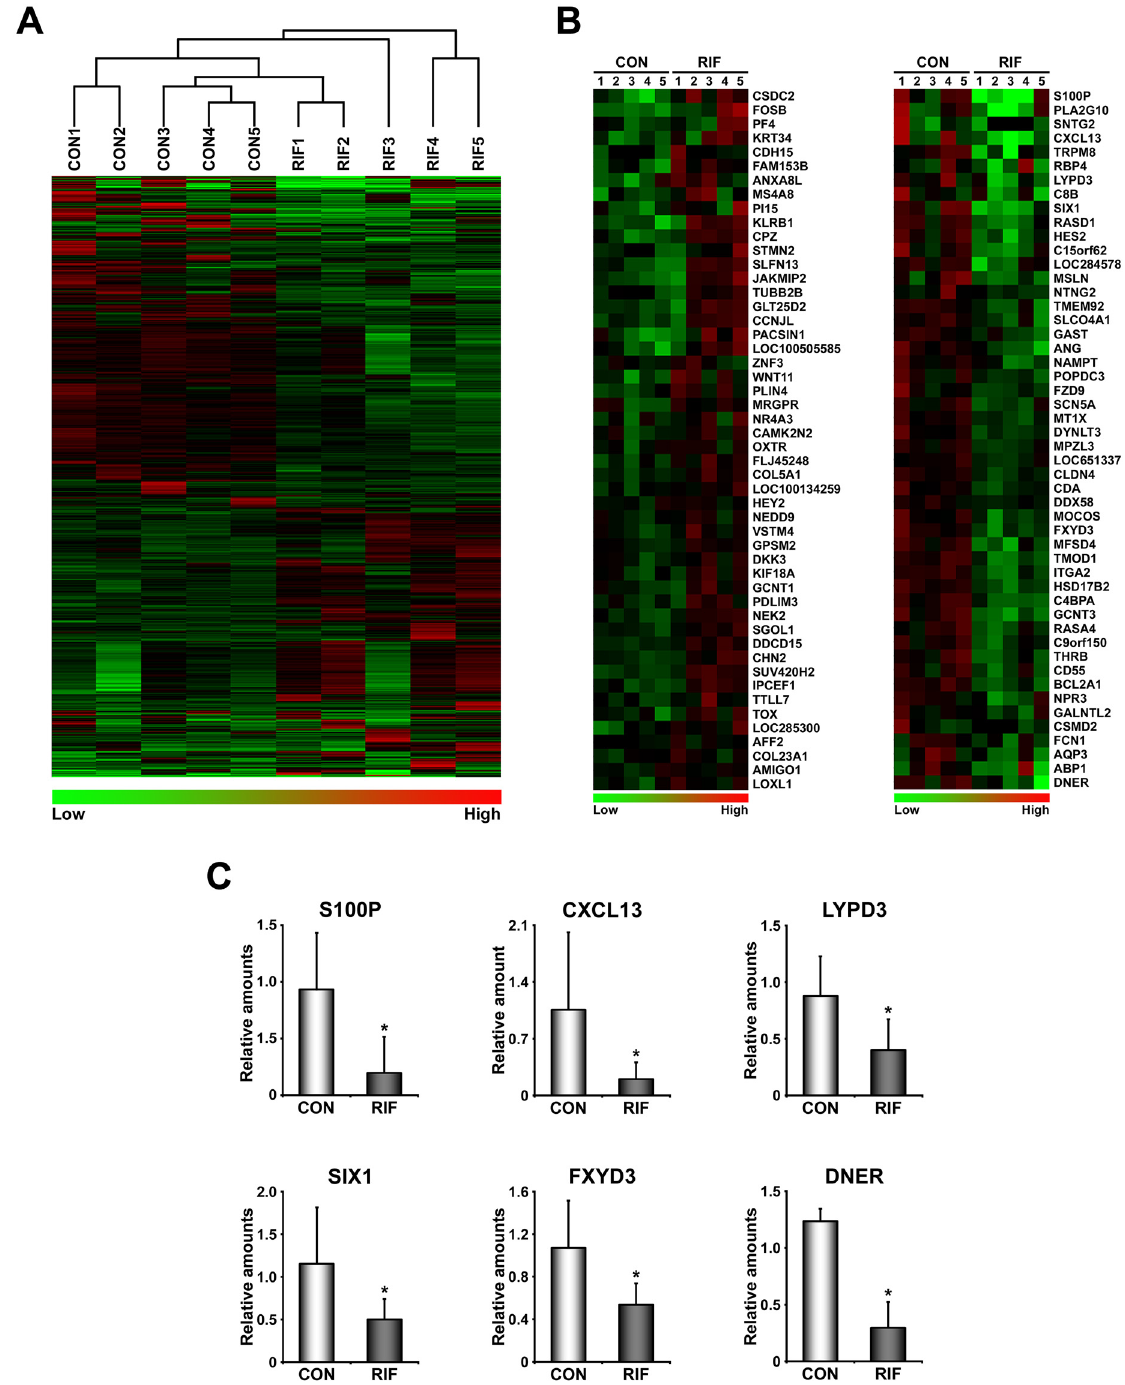
Fig 1. Global expression profiles of the endometrium of patients with RIF are not distinctly different from those of healthy fertile women. A) Unsupervised hierarchical clustering analysis for mRNA microarray data from endometria of healthy women and patients with RIF. B) Heatmaps for the 50 most increased and decreased genes in RIF. The color spectrum from green to red indicates low to high expression. C) Graphs of realtime RT-PCR results for genes whose expression is significantly reduced in RIF. CON and RIF represent endometrium of healthy fertile women and patients with RIF, respectively. * , p < 0.05.